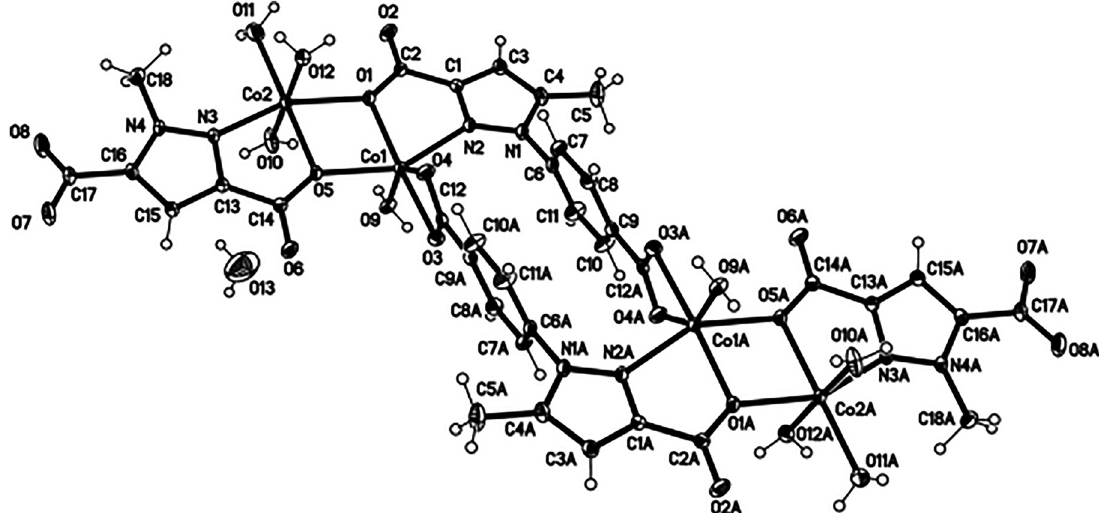
Table  : Data collection and